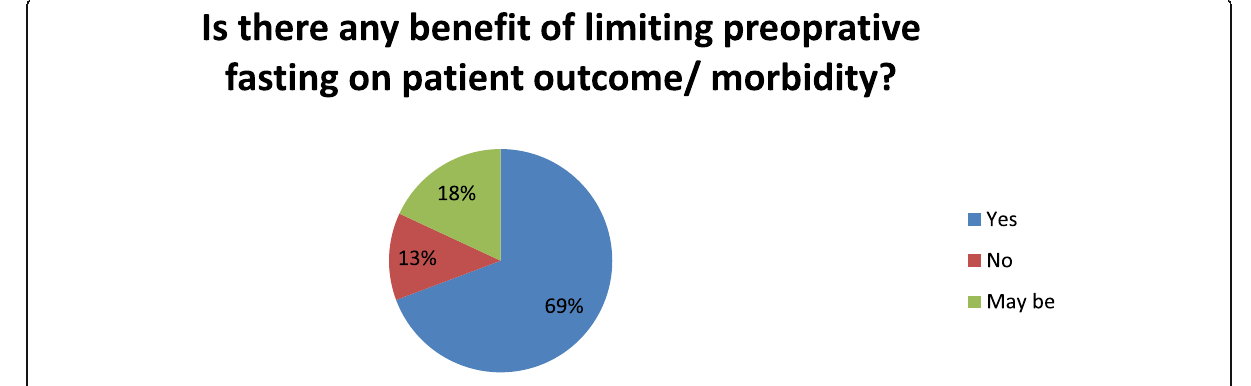
Fig. 3 Summary of knowledge of postgraduate trainees regarding benefit of limiting preoperative fasting